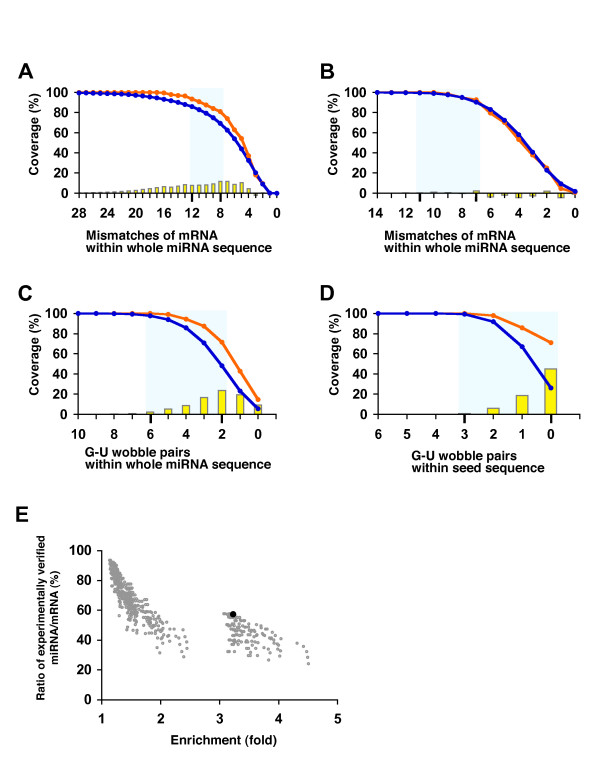
Parameters used for the prediction of miRNA/mRNA pairs and their coverage. To optimize the binding parameters of miRNA/mRNA duplexes, we determined the coverage of four binding parameters (mismatch of mRNA within the whole miRNA sequence (A), mismatch of miRNA within the whole miRNA sequence (B), G-U wobble pairs within the whole miRNA sequence (C), and G-U wobble pairs within the seed sequence (D)). Calculation of the coverage was performed using 112 experimentally verified miRNA/mRNA pairs (orange line) and 153,387 predicted miRNA/mRNA pairs (blue line). The yellow bar indicates differences in coverage between experimentally verified and computationally predicted miRNA/mRNA pairs. Four or five points chosen from the highest yellow bar were used as the range of each of the four binding parameters (blue squares) used in this study. We determined parameter space using the binding patterns of the miRNA/mRNA pairs based on four features (E). Five hundred parameter combinations were plotted on a 2D graph using "ratio of experimentally verified miRNA/mRNA" on the Y-axis and "Enrichment" on the X-axis. Black circles (57.3% of the coverage and 3.2-fold of the Enrichment) indicate the point that corresponded to optimized parameters for the prediction of final conserved miRNA/target pairs: 12 for the number of mismatches in the mRNA, 10 for the number of mismatches in the miRNA, 4 for the number of G-U wobble pairs within the whole miRNA sequence, and 0 for the number of G-U wobble pairs within the seed sequence (see Methods section).